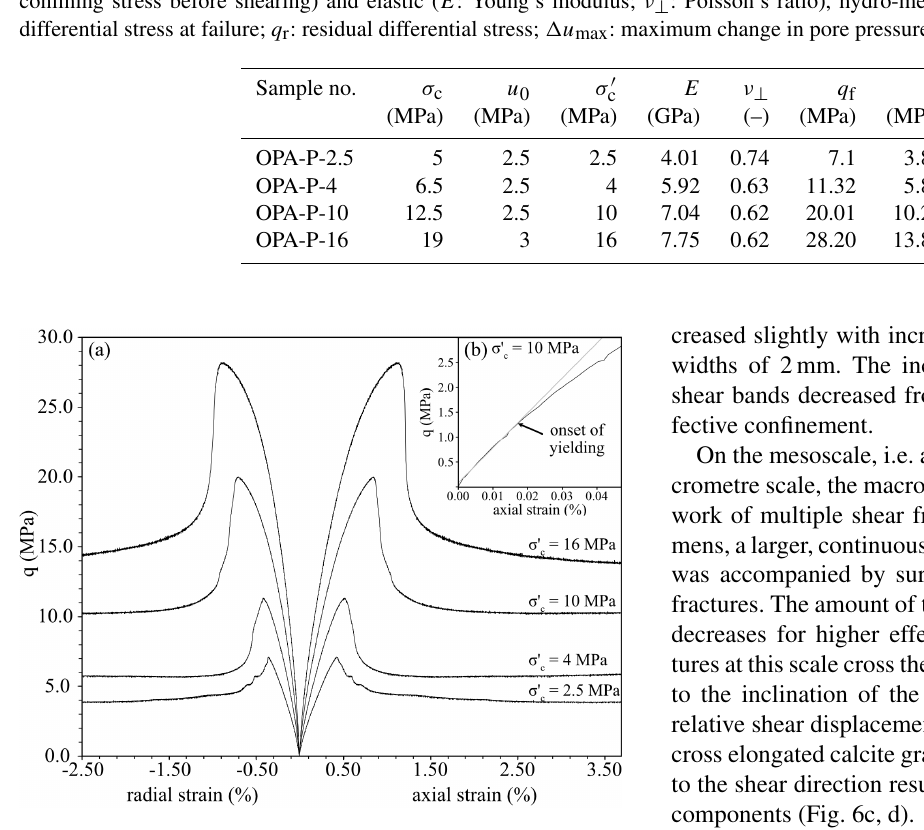
Figure 4. (a) Differential stress–strain curves of all tests, where ra- dial strain is measured normal to the bedding plane. Panel (b) shows the early linear–elastic strain region for test OPA-P-10. The linear fit (grey line) is used to constrain the elastic parameters and the de- viation from linearity, i.e. the onset of yielding.